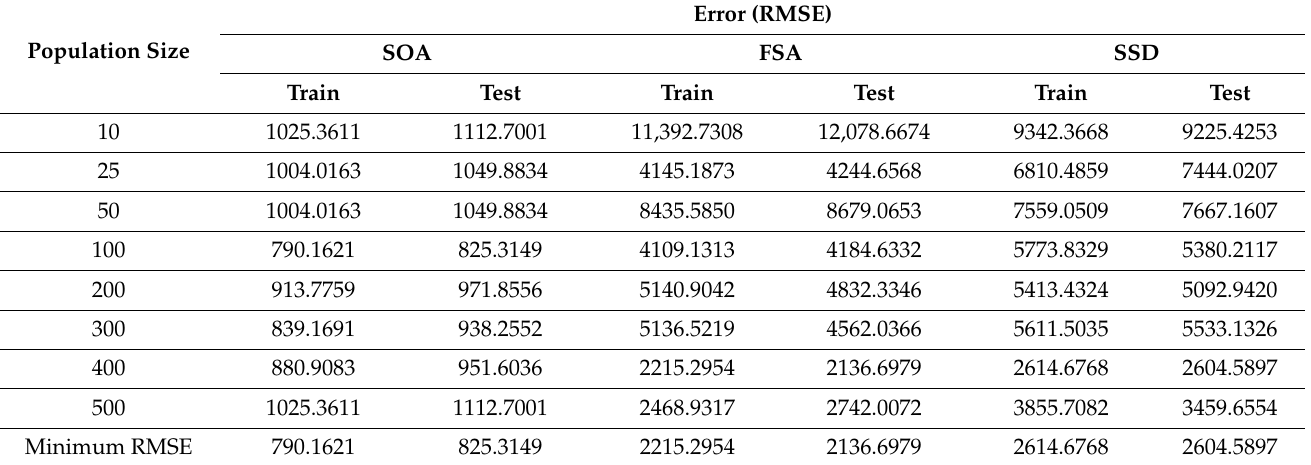
Table 1. Computed errors for different population sizes.